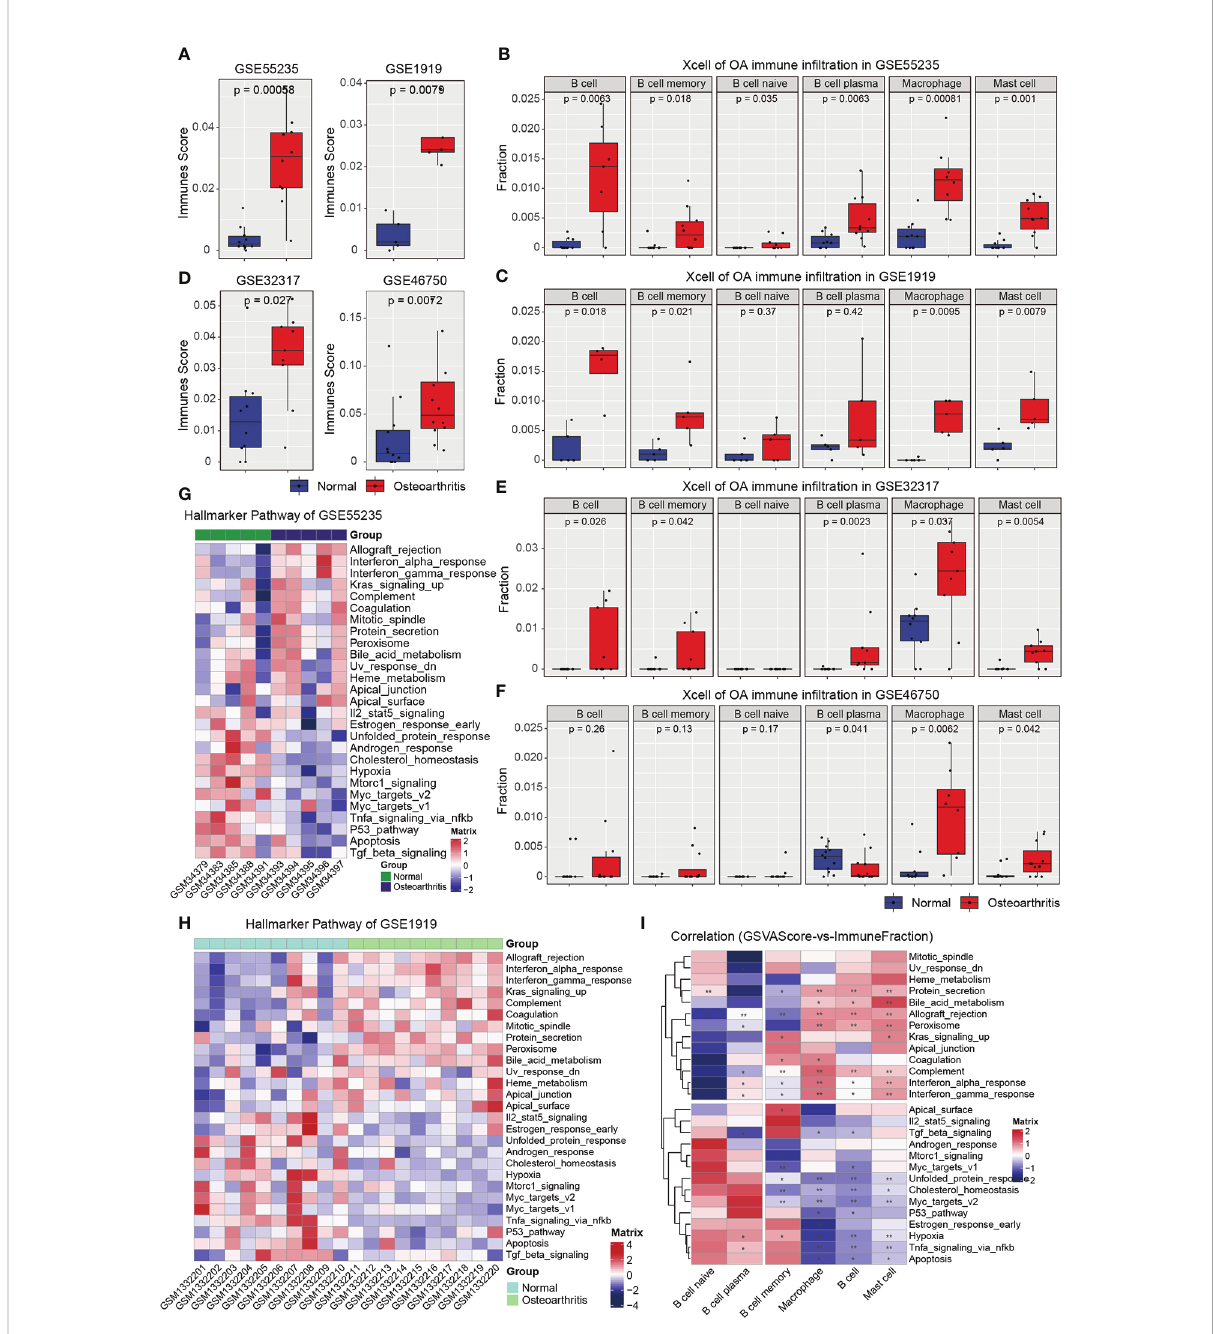
FIGURE 3 Immune in fi ltration analysis and GSVA analysis of OA samples. (A) The immune score of GSE55235 and GSE1919 samples. (B) The immune in fi ltration of GSE55235 samples. (C) The immune in fi ltration of GSE1919 samples. (D) The immune score of GSE32317 and GSE46750 samples. (E) The immune in fi ltration of GSE32317 samples. (F) The immune in fi ltration of GSE46750 samples. (G) Heatmap of Hallmark gsva scores in GSE55235 dataset. (H) Heatmap of Hallmark gsva scores in GSE1919 dataset. (I) Heatmap showed that the spearman correlation between gsva score and immune in fi ltration cell types. (*p < 0.05; **p <